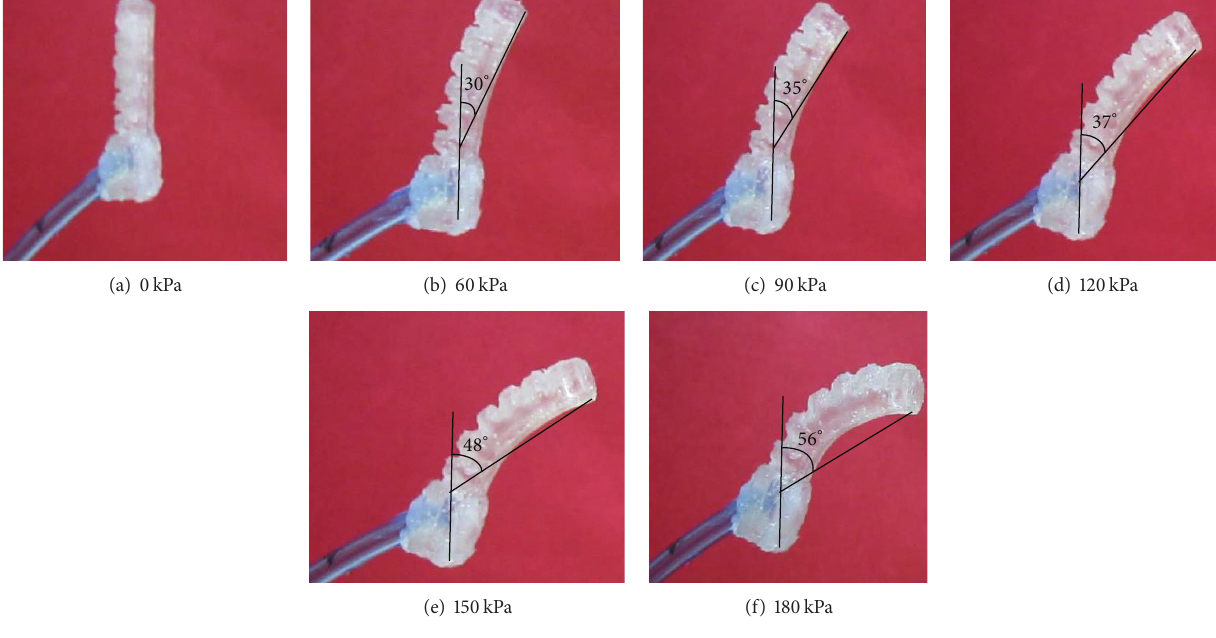
Figure 15: Deflection of the AFPA of model 3 at different pressures.